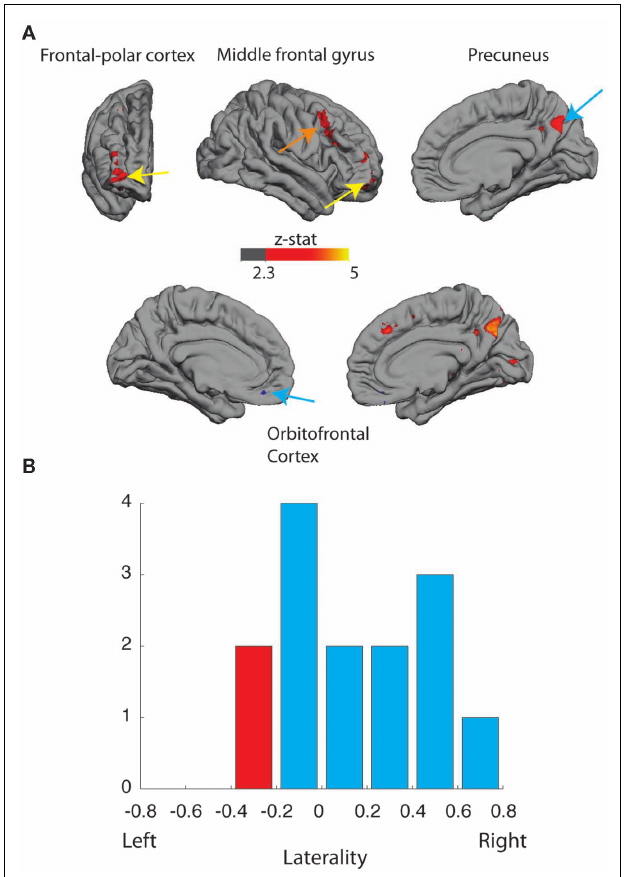
FIGURE 2 | (A) Activation ( Z > 2.3, corrected) to the assignment of authenticity (AUTHENTIC vs. COPY). Upper: frontal, lateral, and medial views of right cortical hemispheres of right-handed participants, greater activation to COPY (red) in right frontopolar cortex (FPC; signal change 0.14%, p < 0.001, Bonferroni corrected); greater activation to COPY (red) in middle frontal gyrus (signal change 0.11%, p < 0.01, Bonferroni corrected); and greater activation to COPY (red) in right posterior precuneus (signal change 0.15%, p < 0.01, Bonferroni corrected). Lower: medial views of left and right cortex; greater activation to AUTHENTIC (blue) in medial orbitofrontal cortex: left, signal change 0.39%, p > 0.05; right, signal change 0.09%, p < 0.01, Bonferroni corrected; and greater activation to COPY (red) in right posterior precuneus. (B) Distribution of lateralization index ( + 1 right-sided, 0 balanced, − 1 left-sided) for FPC activation for right-handed (BLUE) and left-handed (RED) participants.